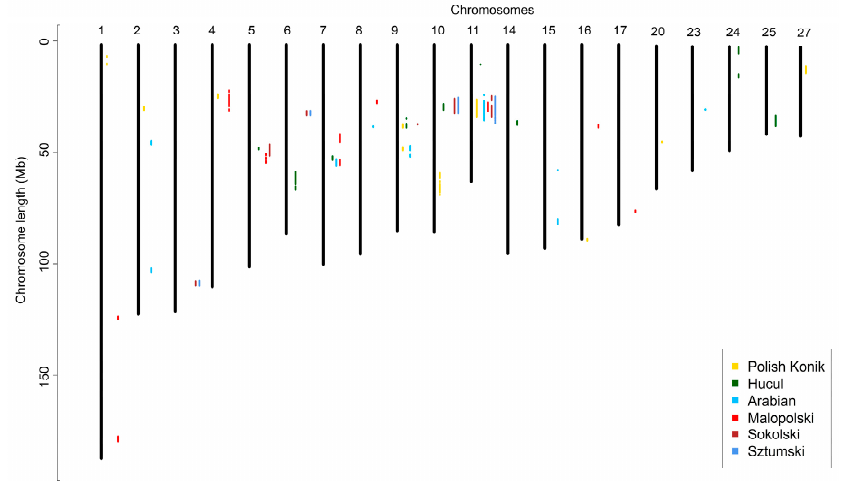
Figure 4. Runs of homozygosity islands detected in analyzed breeds. Regions with a high occurrence of ROH overlapped with a vast number of identified genes—from 76 to 159, depending on the breed. The highest number of genes located within ROH islands were obtained for HC and SZTUM breeds—159 and 137, respectively. This was followed by SOK (121) and KP (110) horses, while lower numbers were visible for AR (90) and MLP (76) breeds. Detailed results are shown in Supplementary Table S6. Regions of no-ROH were calculated for all six breeds, by merging the adjacent SNPs with zero ROH occurrences. This led to the identification of between 2 to 57 no-ROH regions, while the number of regions was strongly linked to the number of individuals in each breed. The lowest number of regions was observed for primitive horses (KP—2; HC—5), followed by AR (6) and SOK (15) breeds. The highest number of regions was shown for SZTUM (57) and MLP (32) horses, however, both breeds represented the lowest number of individuals for which ROH was detected. When considering the size of no-ROH regions, the longest was found in draft horses (SZTUM—from 0.2 to 26.3 Mb and from 7 to 276 SNPs; SOK—from 0.1 to 10.9 Mb and from 5 to 145 SNPs), followed by MLP (from 0.5 to 8.9 Mb and from 9 to 188 SNPs) and HC horses (from 0.2 to 5.8 Mb and from 5 to 74 SNPs), and then by KP (from 2.4 to 3.3 Mb and from 16 to 29 SNPs) and AR horses (0.6 to 2.2 Mb and from 8 to 26 SNPs). The results are shown in Figure 5 and more detail is provided in Supplementary Table